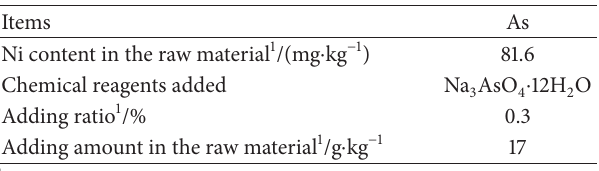
Table 2: Design and materials in experiment. Items